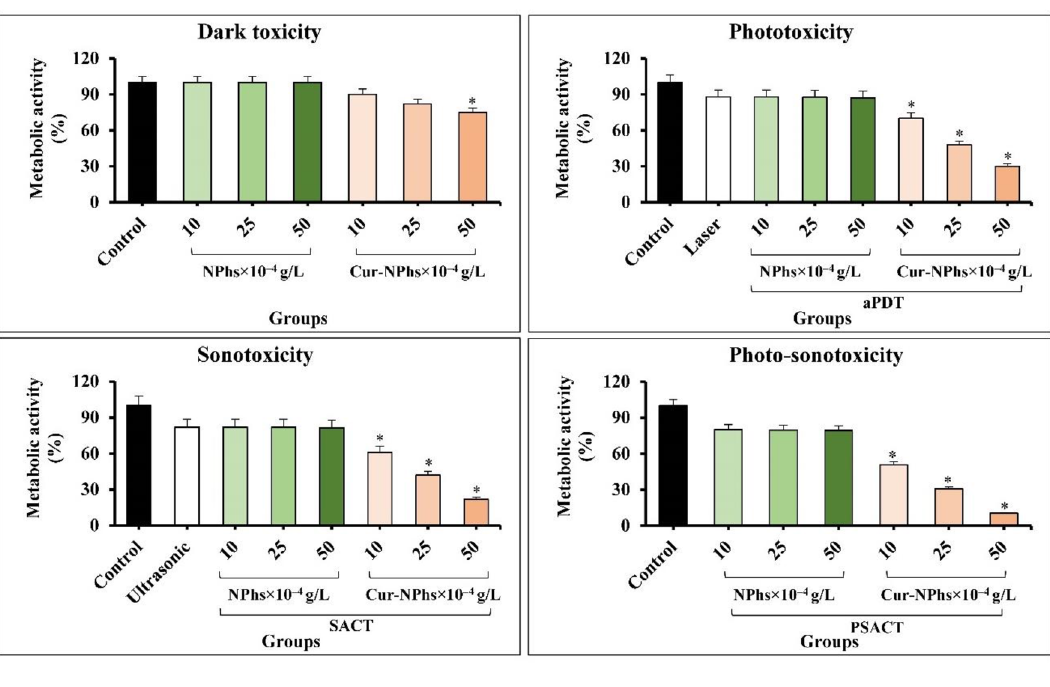
Figure 7. Metabolic activity of A. actinomycetemcomitans following different treatments. Significant differences according to the control, *P < 0.05.